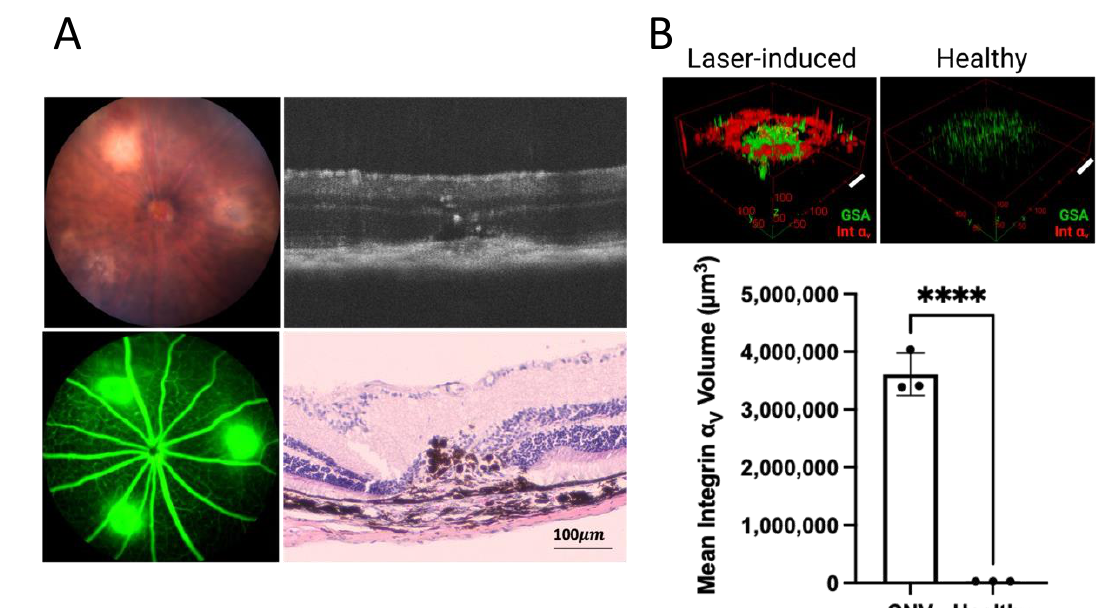
Figure 4. Increased integrin α v expression in choroidal neovascularization in a laser-induced mouse model. CNV induction in a laser-induced mouse model was confirmed by color fundus photography, fluorescein angiography, OCT, and H&E histology ( A ). Volumetric analysis of integrin α v expression within CNV lesions ( n = 3) shows an over 100 times increase in integrin α v expression within CNV lesions compared with the control retina, scale bar, 100 µ m (bar represents mean ± SD, **** p < 0.0001) ( B ).